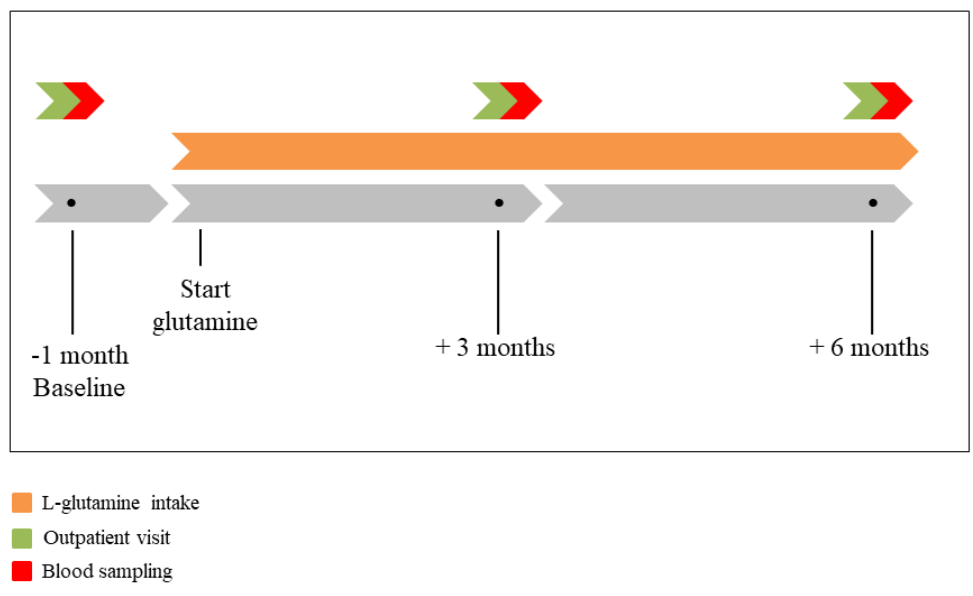
Figure 1. Time course of the Glutaminimize AF project. At baseline, 3-month and 6-month follow-up all patients visited the outpatient clinic (green bar) for electrocardiography and blood sampling (red bar). After one month, patients started with oral intake of the KABI ® Glutamine sachets containing 10 grams of L-glutamine (orange bar), twice daily for a period of six months.